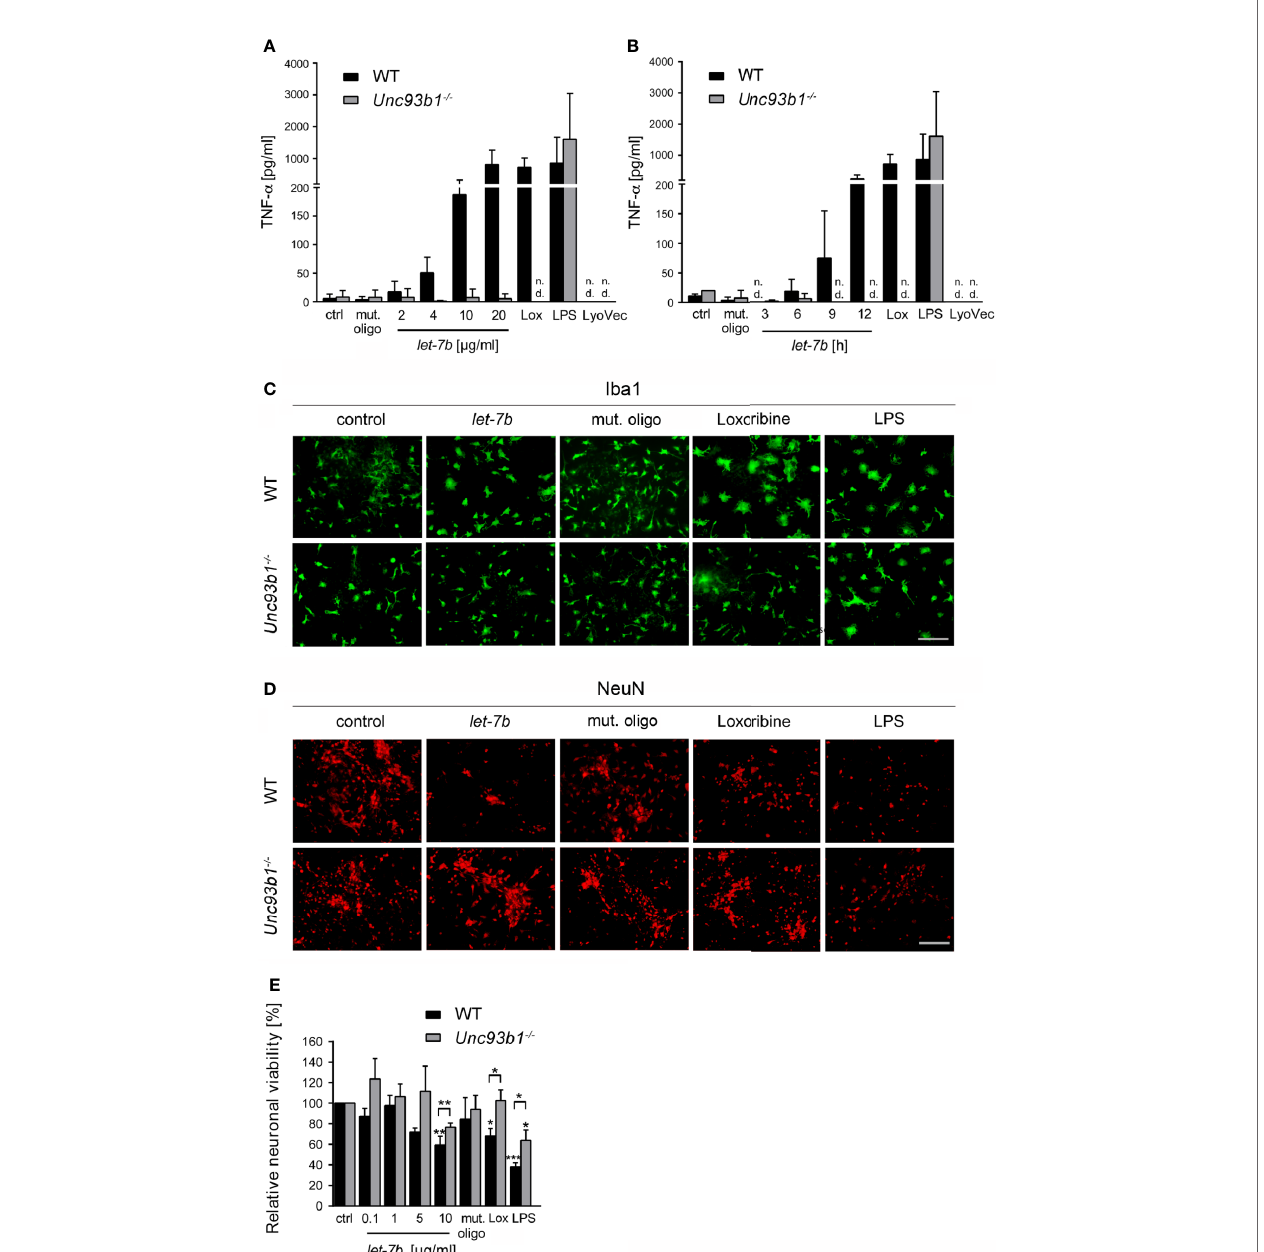
FIGURE 4 | Neuroin fl ammatory response and neuronal injury in response to extracellular let-7b are dependent on UNC93B1 in vitro . Microglia derived from C57BL/ 6 (wild-type, WT) and Unc93b1 -/- mice were incubated with various doses of let-7b oligoribonucleotide, as indicated, for 12 h (A) , or with 10 µg/ml let-7b for various durations, as indicated (B) . Mutant oligoribonucleotide (20 µg/ml, 12 h) and the transfection agent LyoVec served as negative control. LPS (100 ng/ml, 12 h) was used as positive control for microglial TNF- a release through TLR4 activation, while loxoribine (1 mM, 12 h) served as control for TLR7-dependent TNF- a release. Subsequently, supernatants were analyzed by TNF- a ELISA. Results are presented as mean ± SD. n = 4; n.d., not detectable. (C – E) WT neurons co-cultured with either WT or Unc93b1 -/- microglia were treated with various let-7b doses ( C, D : 10 µg/ml for 72 h; E : as indicated for 5 d). Mutant oligoribonucleotide (5 µg/ml) served as negative control, LPS (100 ng/ml) served as positive control for microglial activation, and loxoribine (10 mM) served as positive control for TLR7-dependent microglial activation. Subsequently, co-cultures were immunolabeled with Iba1 (C) and NeuN (D) antibodies to mark microglia and neurons, respectively. Scale bar, 50 µm. (E) Quanti fi cation of NeuN-positive cells in co-cultures treated as described above. Untreated control was set to 100%. For each condition, experiments were performed in duplicates. At least 3 independent experiments were performed. Data are expressed as mean ± SEM. Kruskal-Wallis test was used to determine global signi fi cance over all conditions ( p = 0.0406 over WT and p = 0.0897 over Unc93b1 -/- ). P values of relevant groups (indicated condition vs. unstimulated control, ctrl) were determined by Dunn ’ s multiple comparison test. P values between the respective groups of WT vs. Unc93b1 -/- (in brackets) were assessed by unpaired Student ’ s t test. * p < 0.05; ** p < 0.01; *** p <